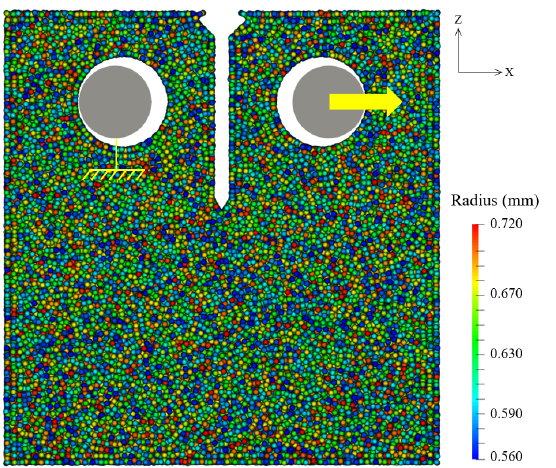
Figure 7. Distribution of the discrete elements radius in a full MS CT specimen. The discrete elements have an average radius of 640µm. Rigid pins are in both holes of the CT specimen.